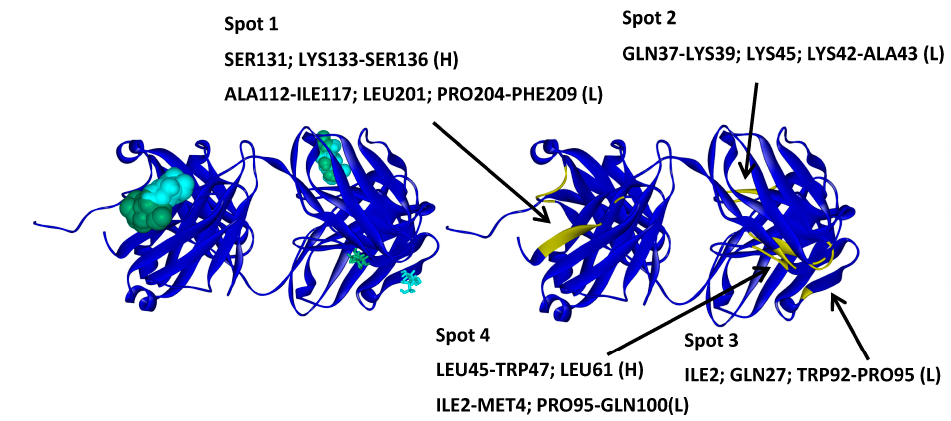
Figure 7. Molecular docking results for mannitol and sorbitol obtained with GLUE software. A33 is displayed in blue ribbons, mannitol in green, and sorbitol in light blue ( left ); The higher affinity molecules are displayed as CPK and lowest as tubes. A33 residues involved in each identified spot ( right ). Table 3. Binding affinity and hotspots for the five lowest energy solutions found for mannitol and sorbitol solutions.